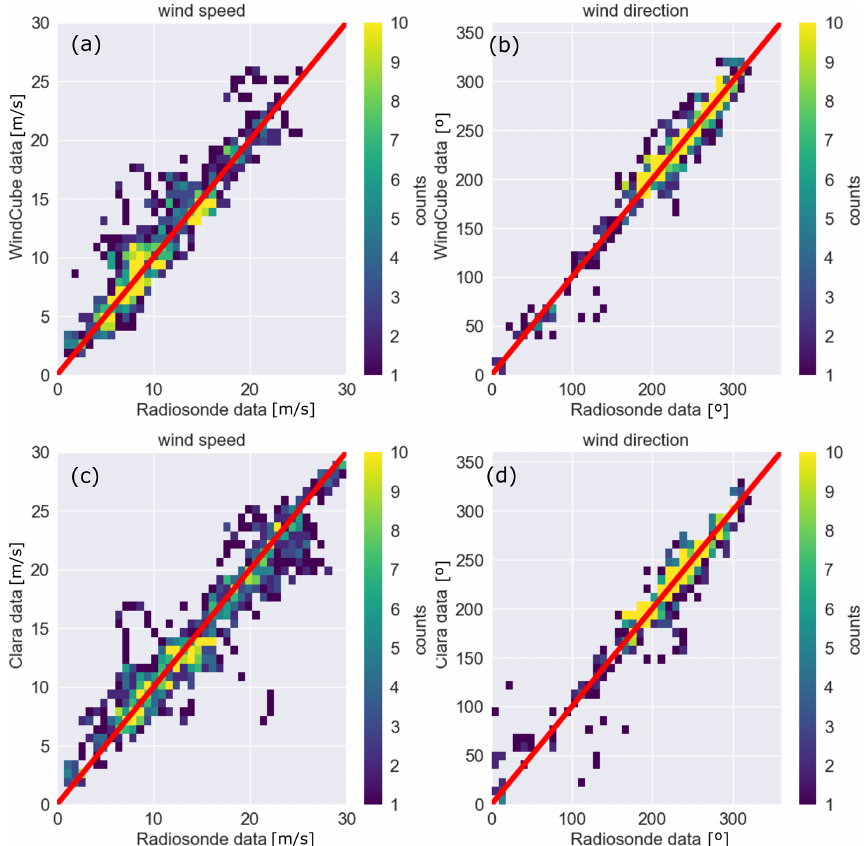
Figure 10. Two-dimensional histograms of wind speed (panels a and c ) and direction (panels b and d ) data retrieved by the WindCube (panels a and b ) and CLARA (panels c and d ) versus all available radiosonde measurements.